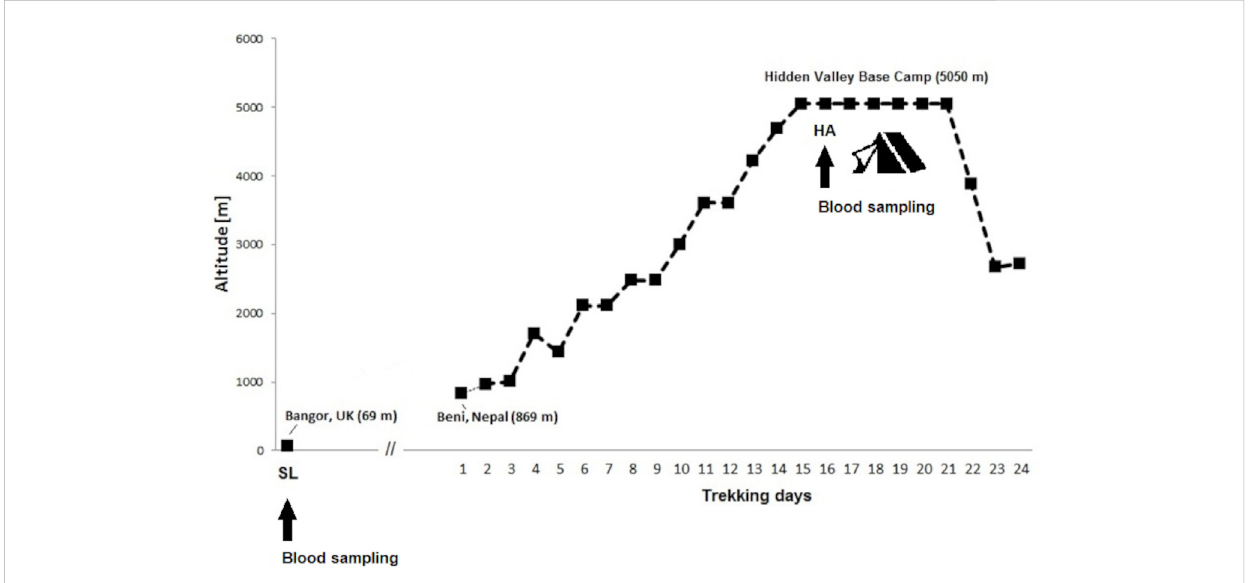
FIGURE 1 Ascent pro fi le for Hidden Valley Base Camp. Data are sleeping altitudes for the expedition. Time points of blood sampling at sea-level (SL 69 m) in Bangor and at high-altitude (HA 5050 m) in the Hidden Valley Base